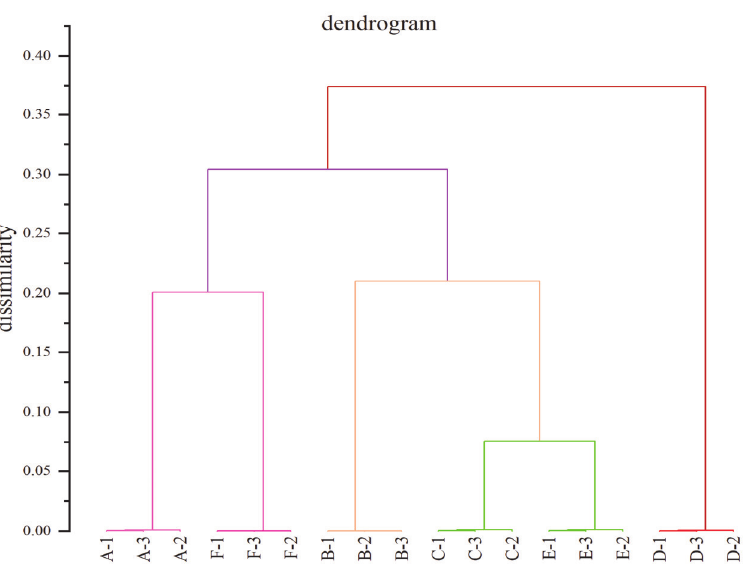
Figure 3. Dendrograms of strong-flavor daqu. A, B, C, D, E, and F represent samples from different periods, respectively.